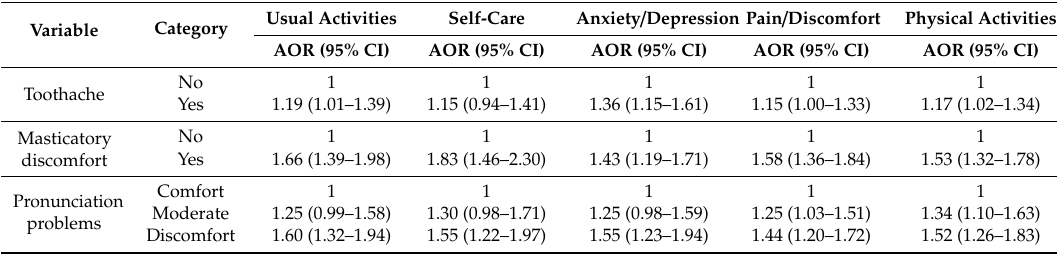
Table 3. Logistic regression analysis for association between oral discomfort problems and five dimensions of